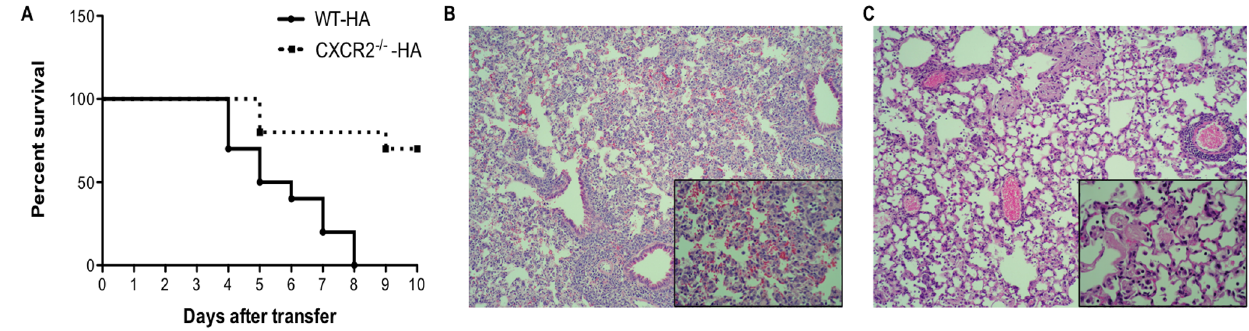
Figure 3. CD8 + T-cell-mediated acute lung injury depends in part on CXCR2 signaling. WT and CXCR2 2 / 2 SPC-HA transgenic mice received 5 6 10 6 WT HA-specific CD8 + T cells via tail vein injection. (A) Survival of mice after T-cell transfer was monitored daily and a striking difference in survival ( P , 0.001) was observed. Representative H&E stained lung sections from (B) WT-HA or (C) CXCR2 2 / 2 -HA mice harvested 5 days after transfer of WT HA-specific CD8 + T cells shown at 10x magnification with 40x inset. Data are representative of at least two independent experiments with 4-5 mice per group.